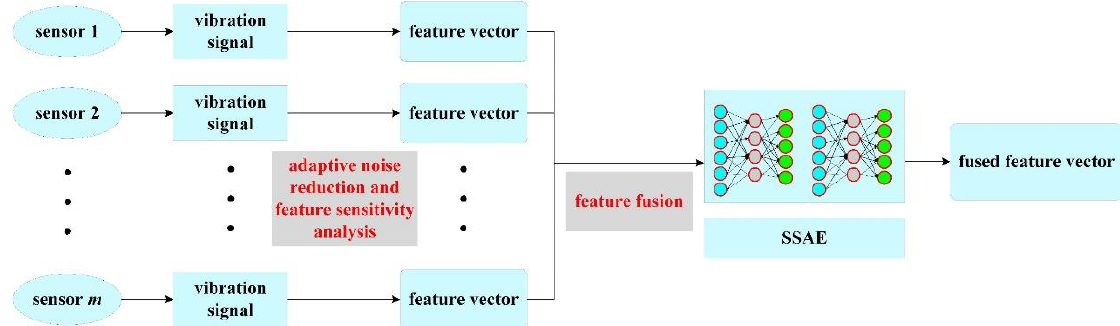
Figure 4. Schematic diagram of the multi-channel feature values fusion process.